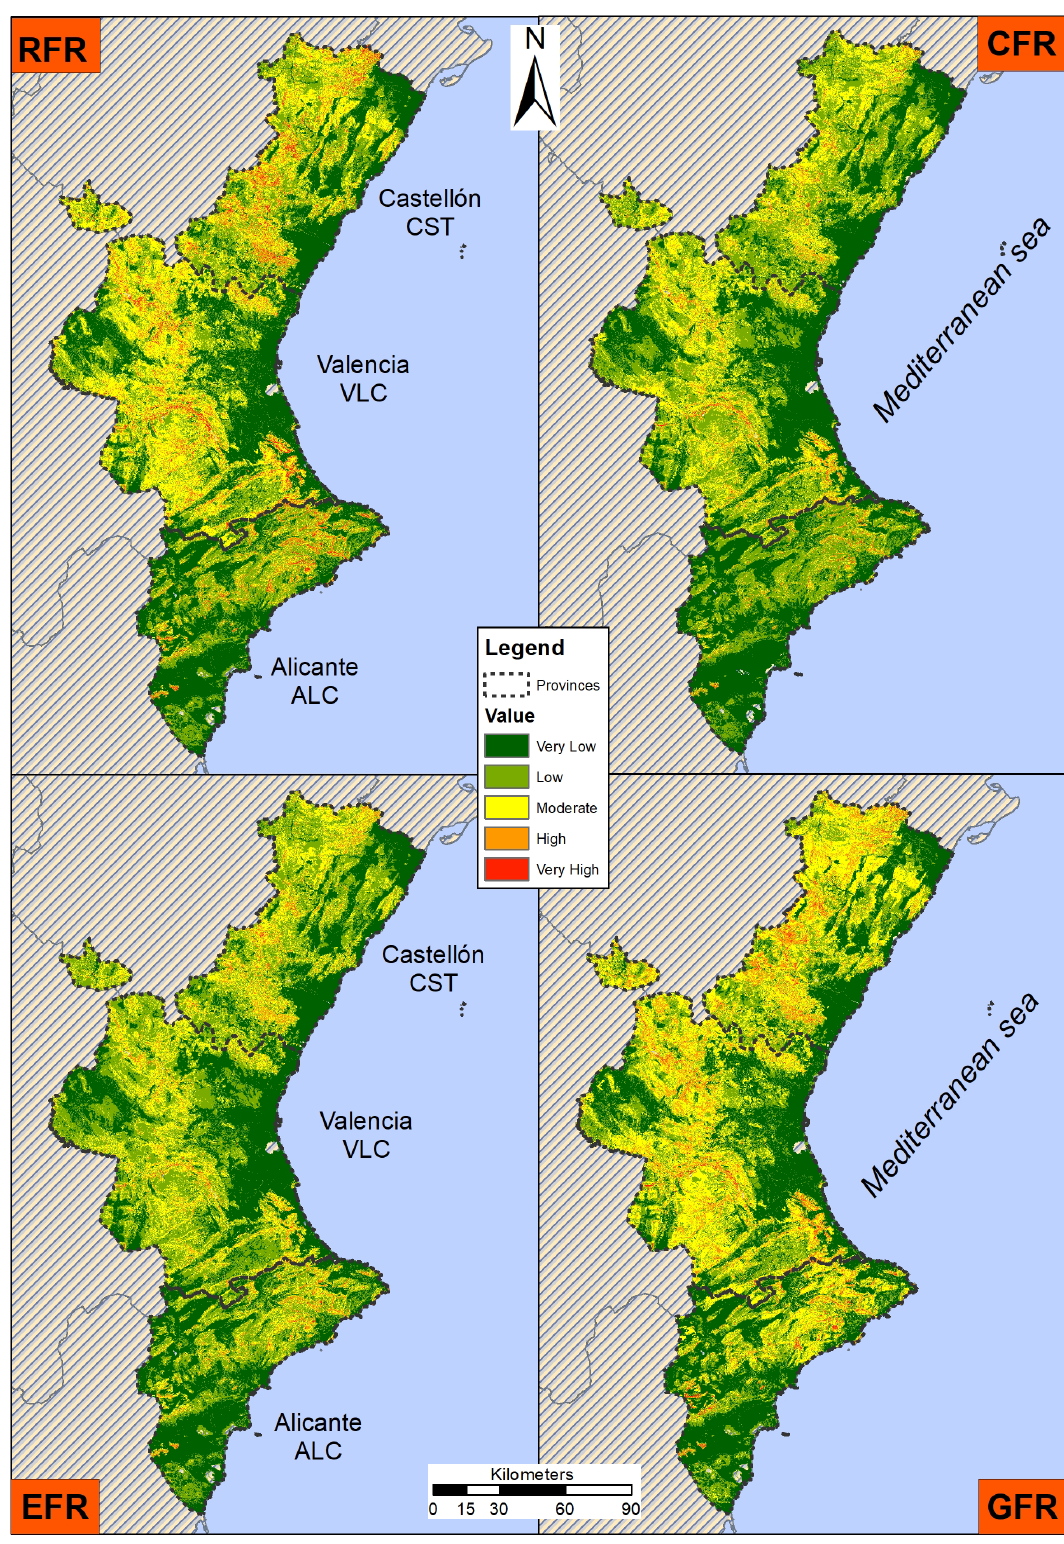
Figure A1. LSM with Natural Breaks classification.